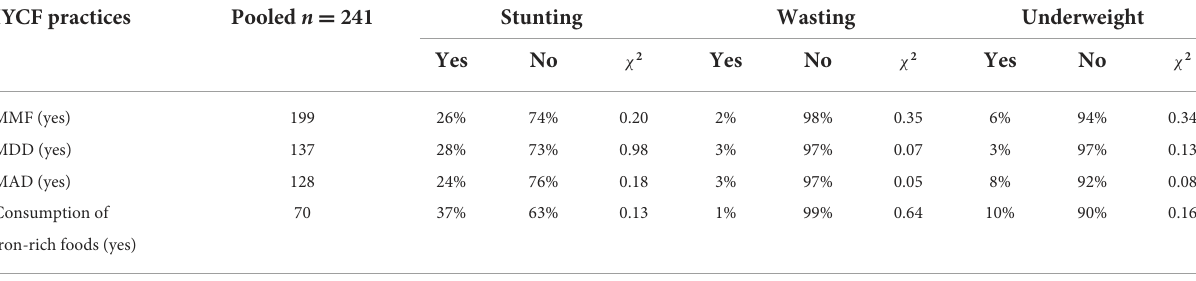
TABLE 5 Association of IYCF practices with nutritional status of children. IYCF practices